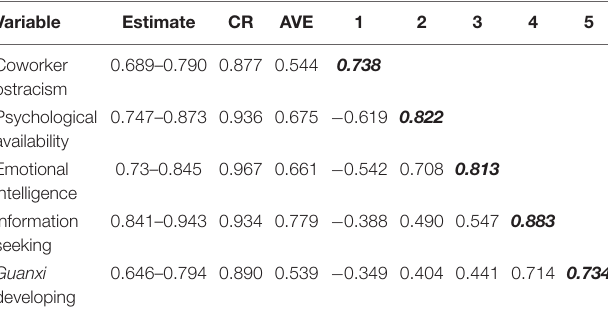
TABLE 1 | Results of confirmatory factor analysis of each